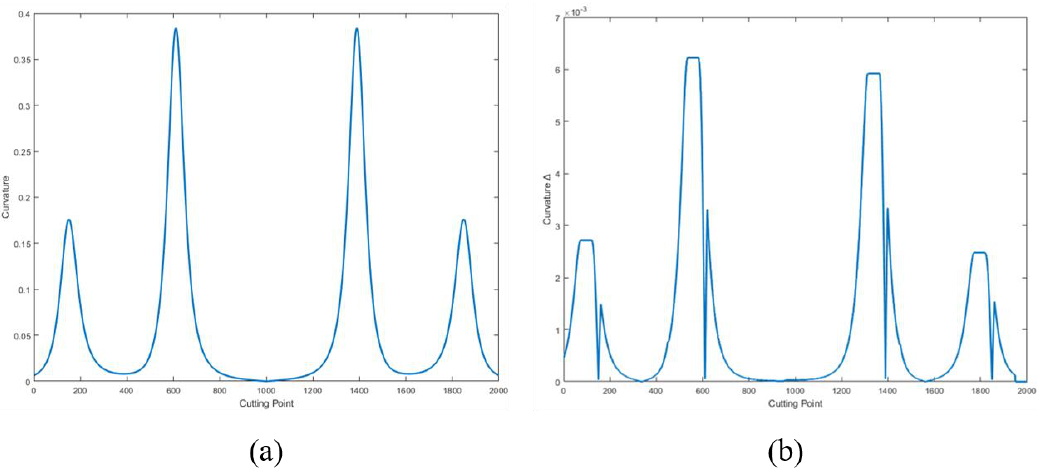
Figure 8. ( a ) Curvature and ( b ) curvature variation of ∞ shape.